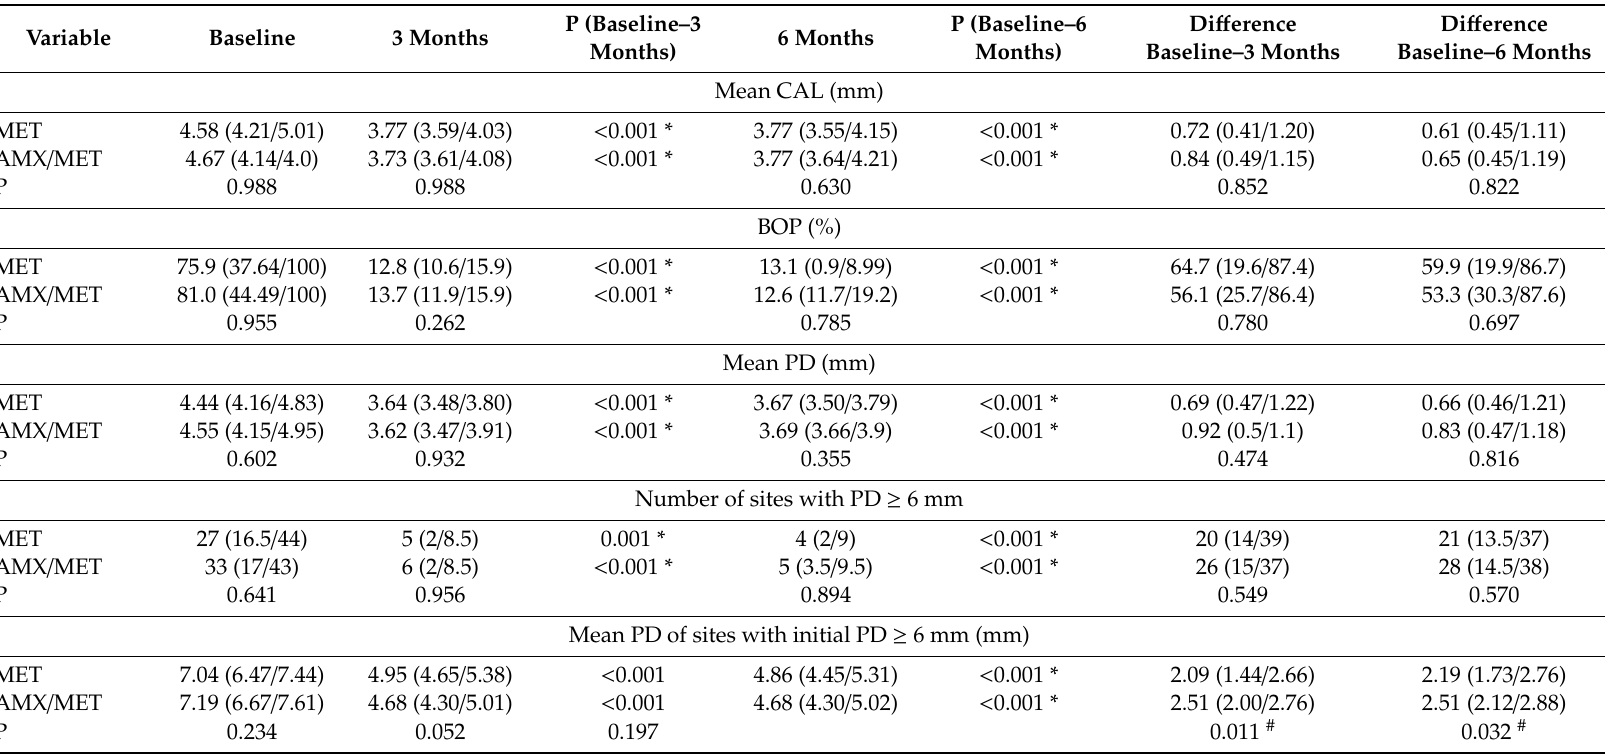
Table 2. Clinical variables (median, 25 percentile, 75 percentile) at baseline, after three and six months in the MET (subgingival instrumentation + metronidazole; n = 29) and the AMX / MET groups (subgingival instrumentation + metronidazole / amoxicillin; n =